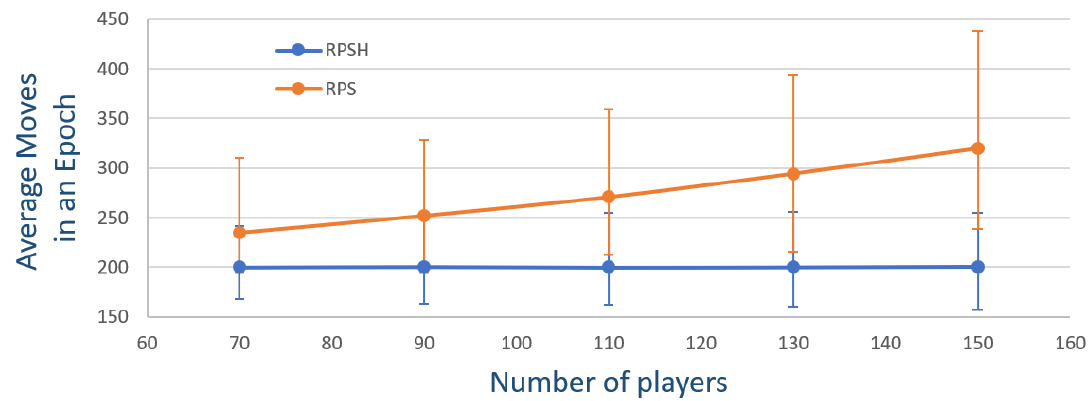
Figure 6. Average moves needed in RPS and RPSH protocols with 200 nodes.